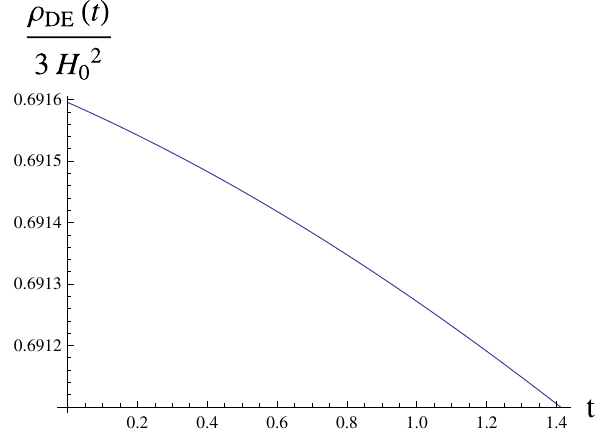
. In 100 km 100 km